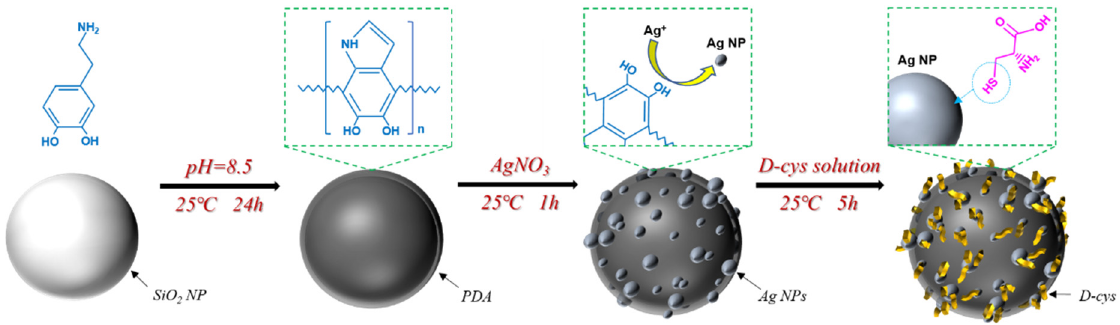
Figure 1. Schematic illustration of the preparation procedure of antibacterial nanoparticles.